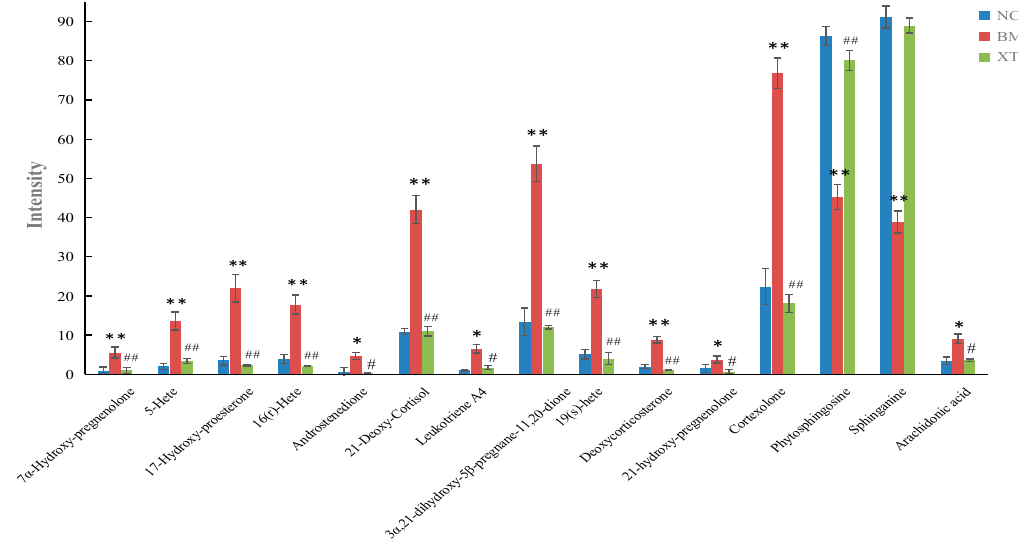
Figure 7. The normalized intensity of differential metabolites in different groups (* P < 0.05, ** P < 0.01 vs. NC group; # P < 0.05, ## P < 0.01 vs. BM group).